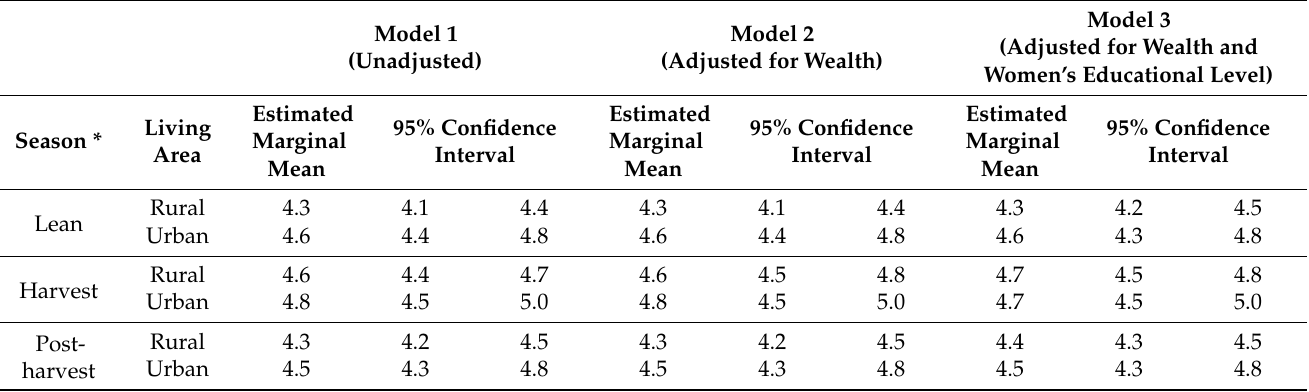
Table 4. Estimated marginal means with 95% CI women’s dietary diversity scores across three different seasons adjusted for wealth (Model 1) and wealth and educational level (Model